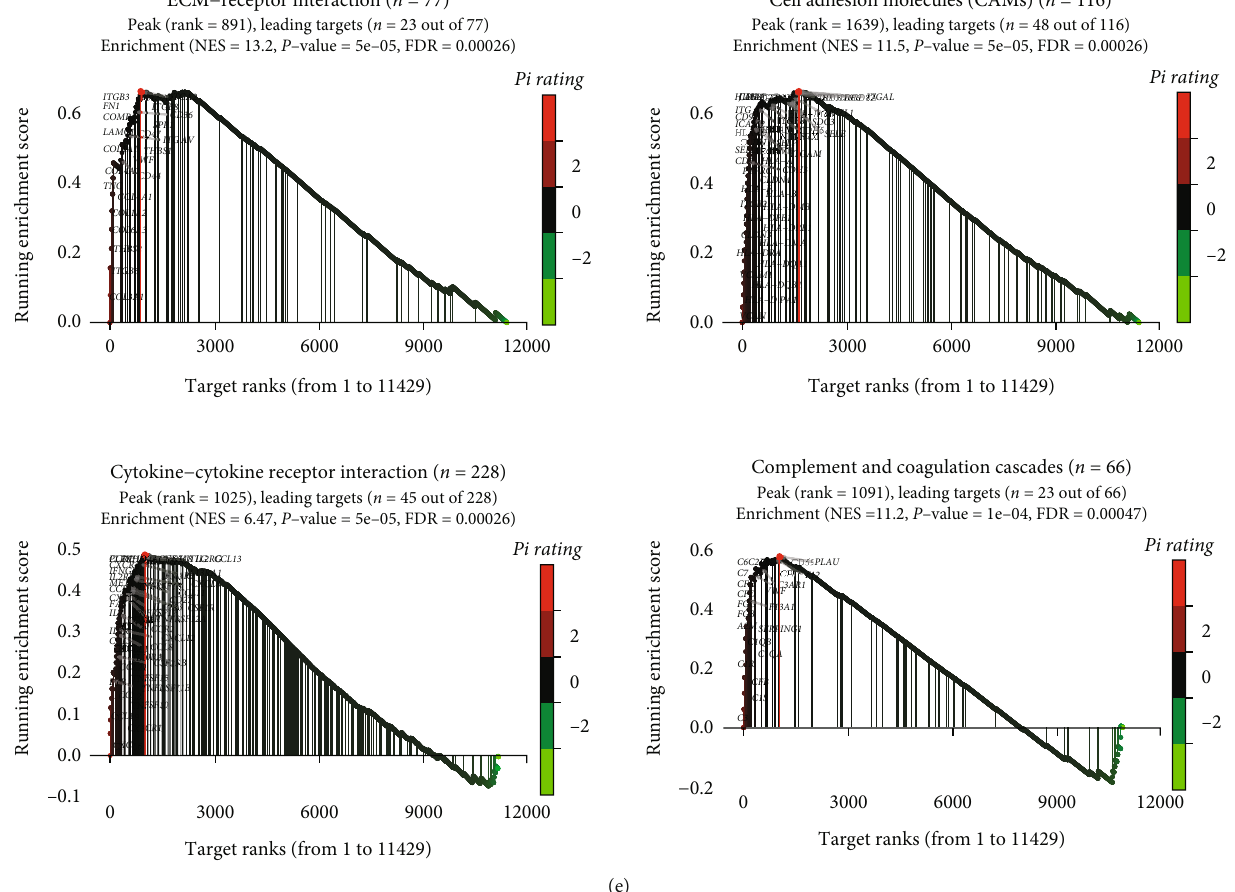
Figure 3: Identi fi cation and enrichment analyses of DEGs related to tubulointerstitial injury in DN. (a) Volcano plot of di ff erential expressed genes (DEGs) between DN and LD tubule samples. The x -axis corresponds to log corresponds to – log transformed P value. (b) Heat map of DEGs among 2 groups. (c, d) GO and KEGG pathway enrichment results 10 for DEGs. (e) GSEA between the DN and LD groups. DEG: di ff erentially expressed gene; GSEA: gene set enrichment